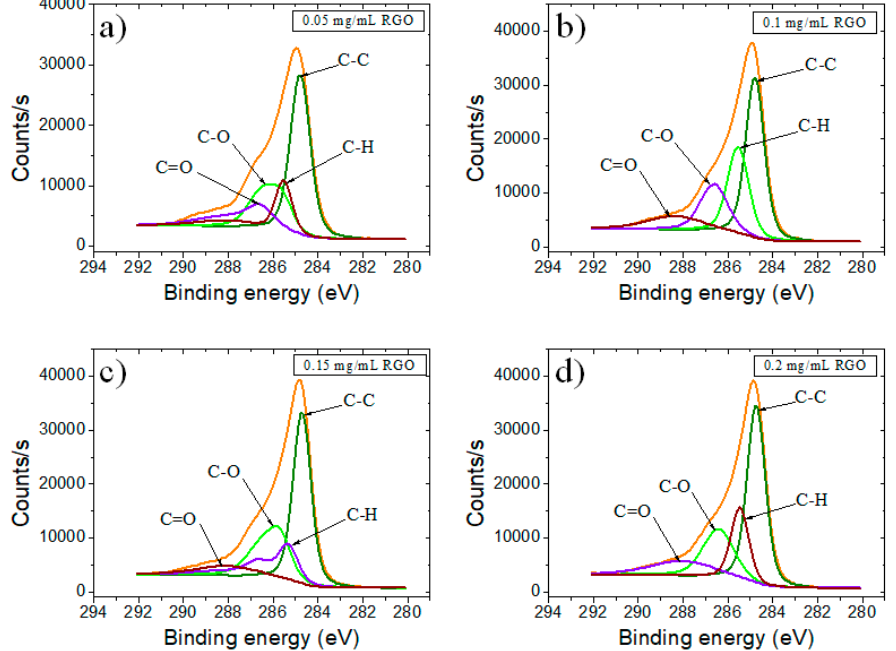
Figure 4. High-resolution C1 XPS spectra of SPCE modified with RGO using as precursor ( a ) 0.05 mg / mL GO; ( b ) 0.1 mg / mL GO; ( c ) 0.15 mg / mL GO; and ( d ) 0.2 mg / mL GO.